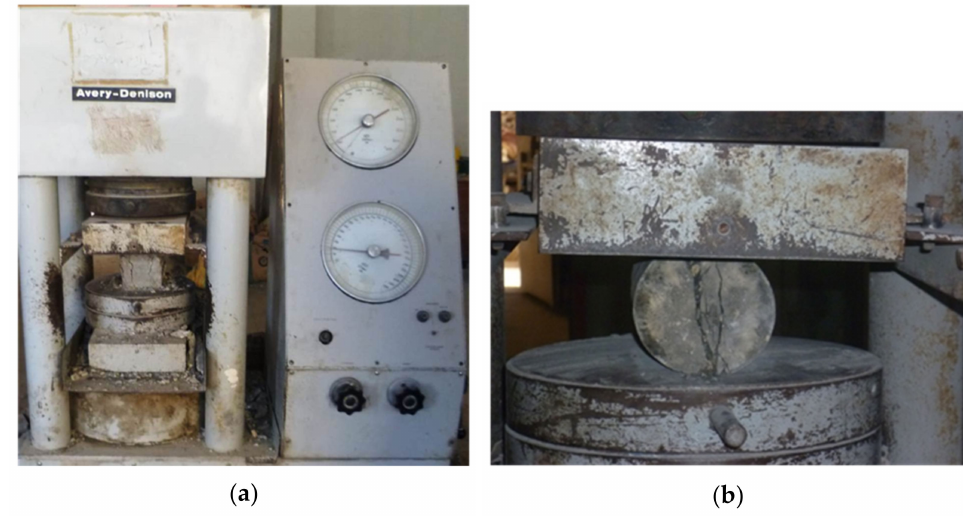
Figure 2. Test setup for ( a ) compression test and ( b ) indirect tensile